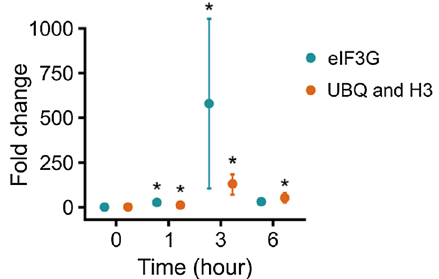
Figure 7. KnABC transcripts accumulation under salt stress condition relative to control. Each dot represents the mean of six biological repetitions, error bars represent standard errors of the mean. The quantification was normalized with the worst reference gene candidate eIF3G in blue or with the optimal pair of reference genes UBQ and H3 in orange. Statistically significant differences between NaCl treatment and control were determined using Kruskal–Wallis followed by Dunn test (* P <